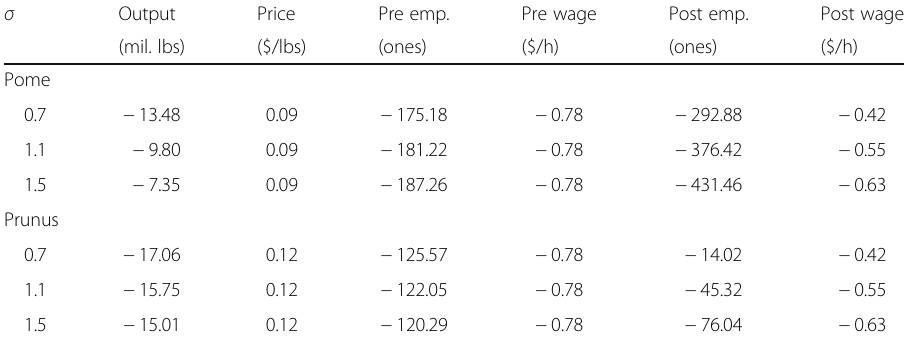
Table 9 Pre- and post-shock commodity and labor equilibrium level change σ Output Price Pre emp. Pre wage Post emp. (mil. lbs)